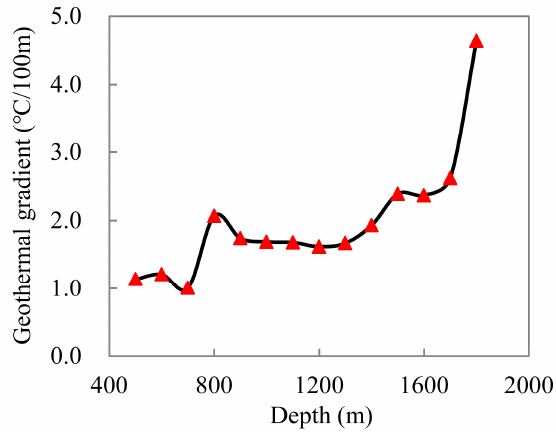
Figure 9. Temperature gradient vs. depth.